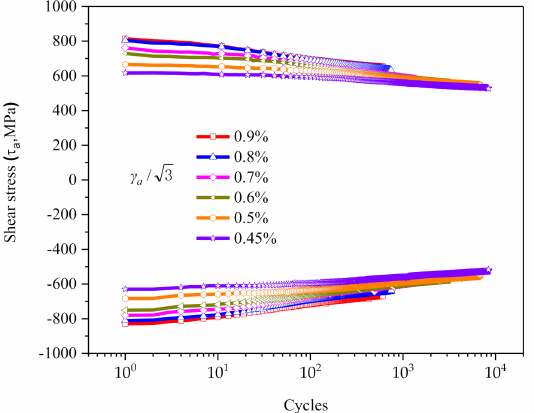
Figure 4. Variation of maximum/minimum shear stress versus number of cycles at different strain